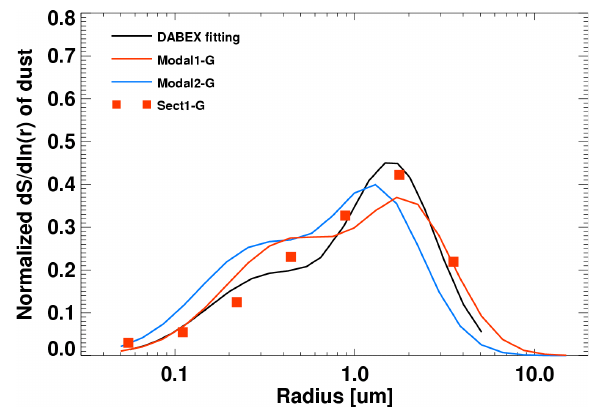
Figure 5 Normalized cross-sectional area size distributions of mineral dust from the fitting of DABEX aircraft measurements and the WRF-Chem simulations in three cases (Modal1-G, Modal2-G, and Sect1-G). Cross-sectional areas of particles are calculated as πr 2 , where r is the radius of a particle.